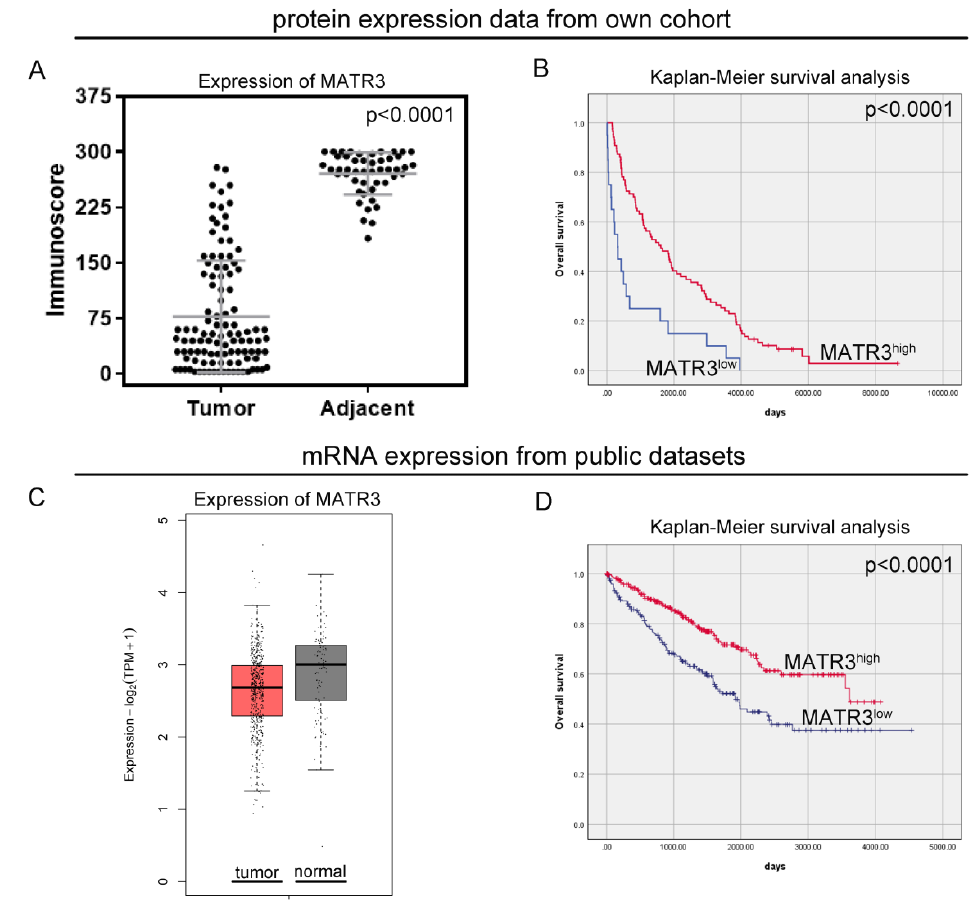
Figure 2. Protein and mRNA expression of MATR3 in ccRCC. Immunohistochemical ( A ) and mRNA ( C ) expression of MATR3 in clear cell renal cell carcinoma (ccRCC) compared to normal tissues. ( B ) Kaplan – Meier survival curves for overall survival of ccRCC patients based on ( B ) MATR3 protein expression and ( D ) MATR3 mRNA expression. Figure prepared using Adobe Photoshop software. Table 1. MATR3 protein expression and its relationship with clinicopathological features of clear cell renal cell carcinoma (ccRCC) patients in our cohort. “ - “ indicates low expression; “ + ” indicates high expression.